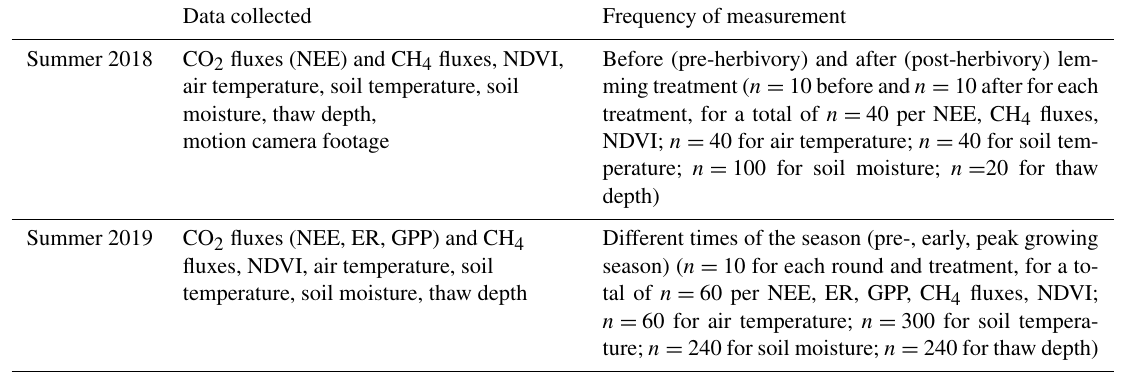
Table 1. Types of data collected and when they were measured during summer 2018 and summer 2019. All data were collected while lemmings were not present inside the experimental plots, except for the motion camera footage. NEE is defined as net ecosystem exchange, ER as ecosystem respiration, GPP as gross primary production, and NDVI as the normalized difference vegetation index. Data collected Frequency of measurement Before (pre-herbivory) and after (post-herbivory) lem- Summer 2018 CO 2 fluxes (NEE) and CH 4 fluxes, NDVI, ming treatment ( n = 10 before and n = 10 after for each air temperature, soil temperature, soil treatment, for a total of n = 40 per NEE, CH 4 fluxes, moisture, thaw depth, NDVI; n = 40 for air temperature; n = 40 for soil tem- motion camera footage perature; n = 100 for soil moisture; n = 20 for thaw depth) Different times of the season (pre-, early, peak growing Summer 2019 CO 2 fluxes (NEE, ER, GPP) and CH 4 season) ( n = 10 for each round and treatment, for a to- fluxes, NDVI, air temperature, soil tal of n = 60 per NEE, ER, GPP, CH 4 fluxes, NDVI; temperature, soil moisture, thaw depth n = 60 for air temperature; n = 300 for soil tempera- ture; n = 240 for soil moisture; n = 240 for thaw